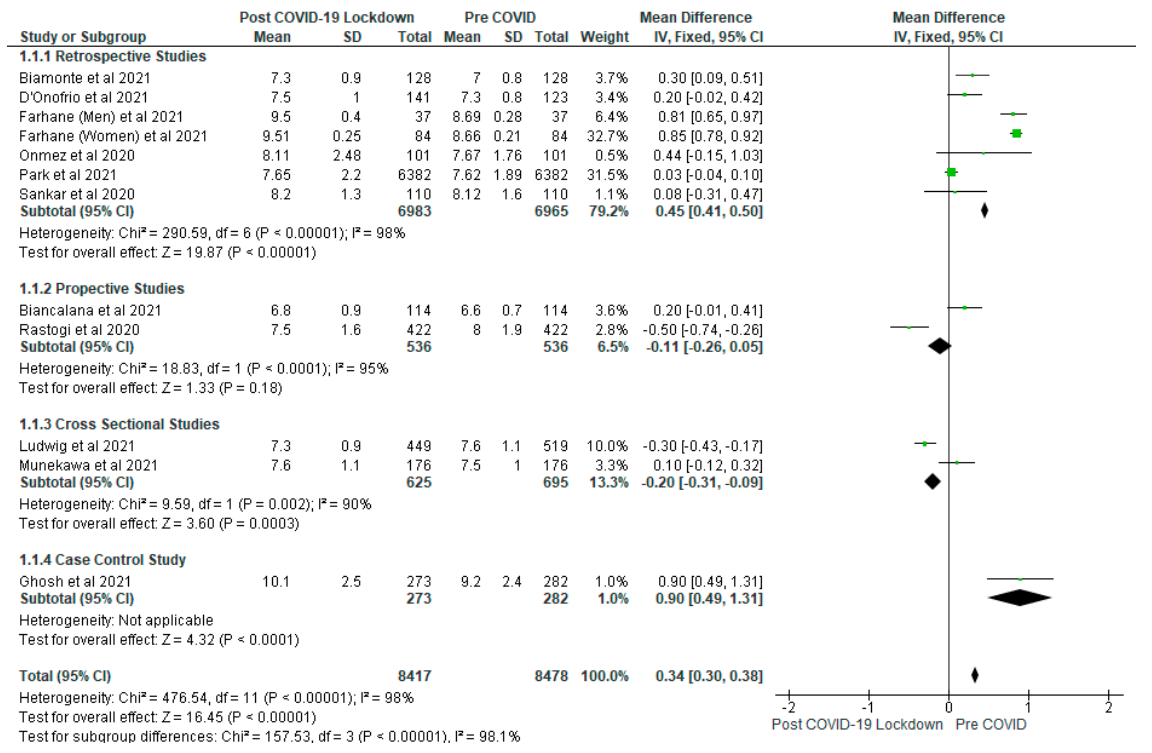
Figure 3. The effect of COVID-19 lockdown on Glycated Haemoglobin (%).